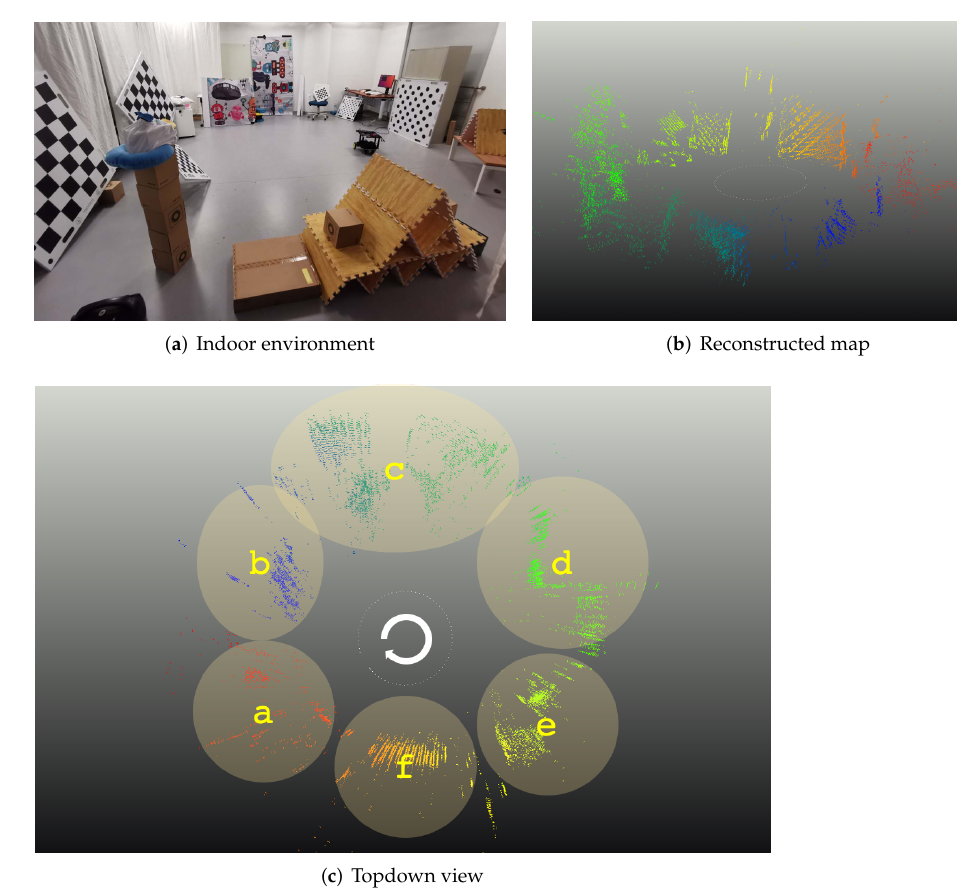
Figure 8. Reconstruction of an indoor scene. ( a ) shows a real image of the environment. ( b , c ) are different perspectives onto the reconstructed structure.